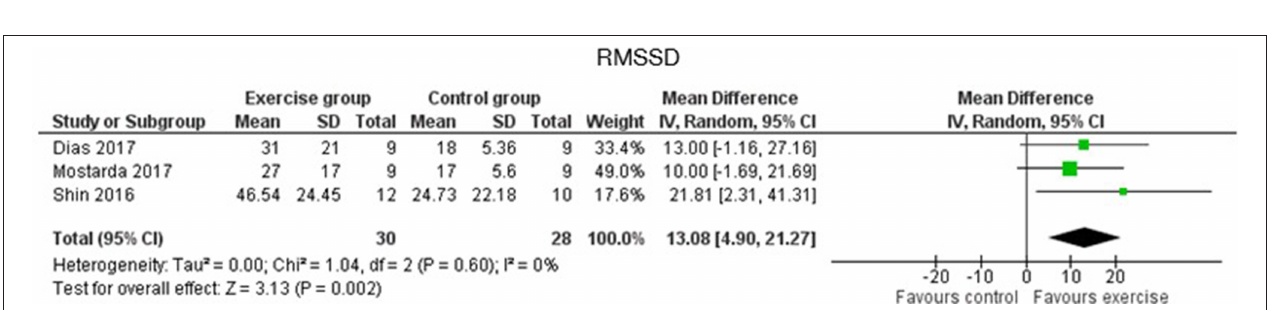
FIGURE 3 | Effects of exercise in RMSSD (root mean square of successive differences between normal heartbeats) heart rate variability measure.